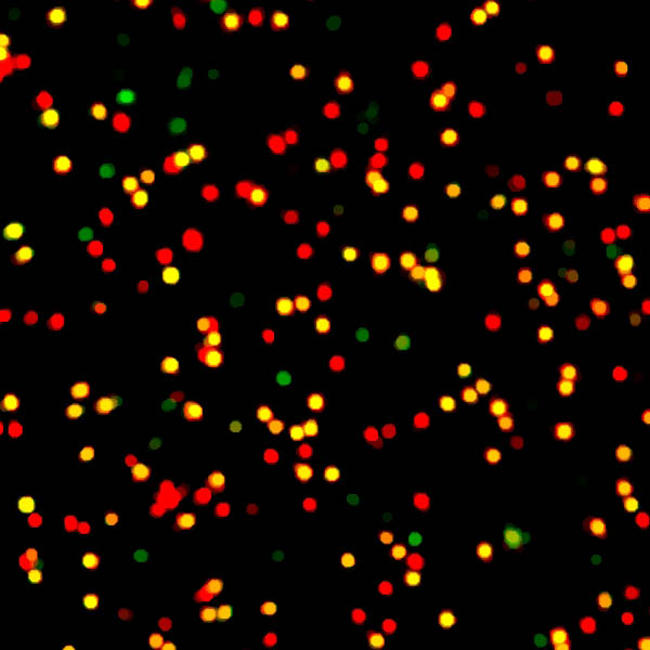
CD4 Cell Measurement Using a Prototype Microchip Counting Method This is a digital image of whole blood from a five-month-old male infant from Botswana with an absolute CD4 count of 2,098 cells/ml and a CD4 percentage of T cells of 0.39, obtained using a prototype method for low-cost CD4 count monitoring. CD4+ T cells are yellow. Also visualized are monocytes (green) and CD8+ T cells (red). (Photo courtesy of the authors of [8])